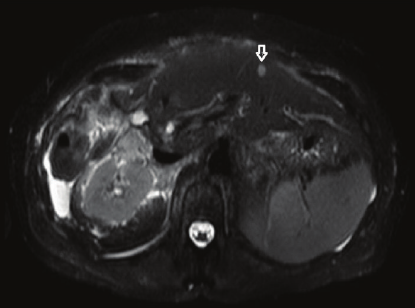
Figure 4: Postoperative follow-up MRI (small white arrow indicates new suspicious